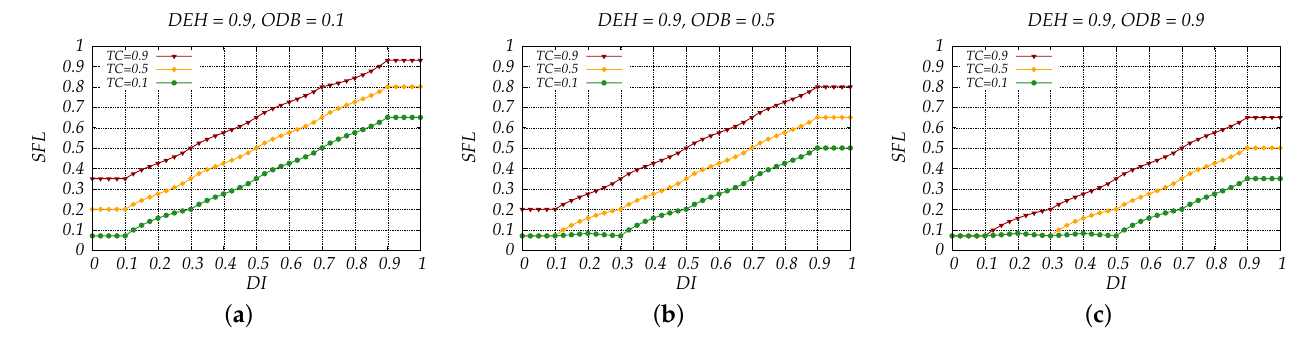
Figure 8. Simulation results showing the effect of ODB, TC, and DI on the determination of driver stress when DEH = 0.9. ( a ) DEH = 0.9, ODB = 0.1, ( b ) DEH = 0.9, ODB = 0.5, ( c ) DEH = 0.9, ODB =